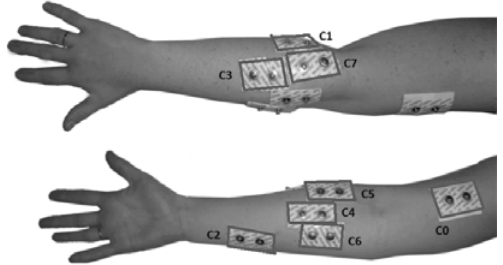
Figure 4. Picture showing the electrodes positions in the same arm (right arm).